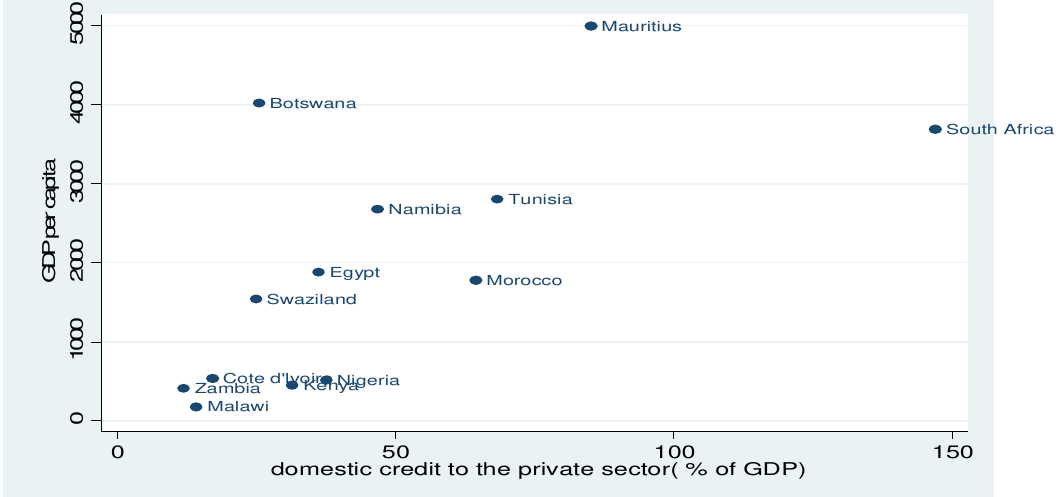
Fig. 8. GDP per capita and domestic credit to private sector